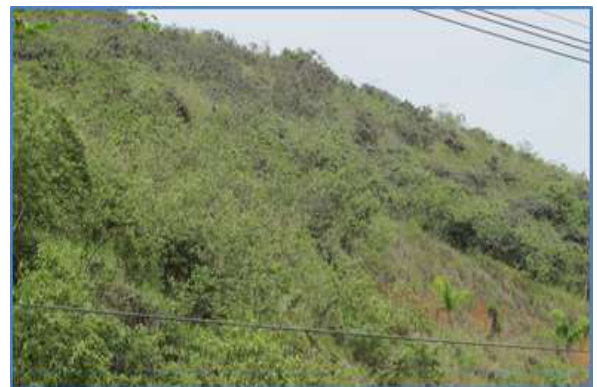
Figure 3. Types of vegetation -